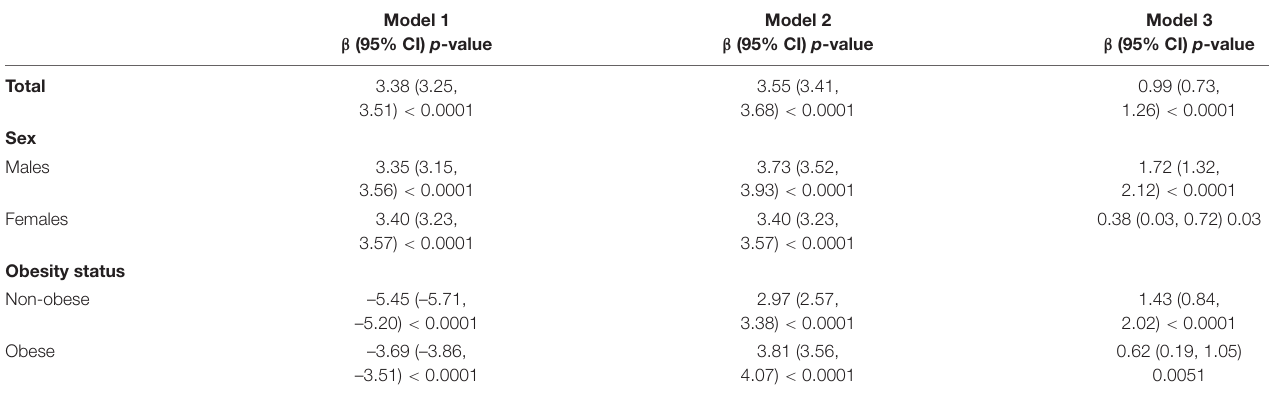
TABLE 2 | The association between total percent fat (%) and serum uric acid ( µ mol/L).